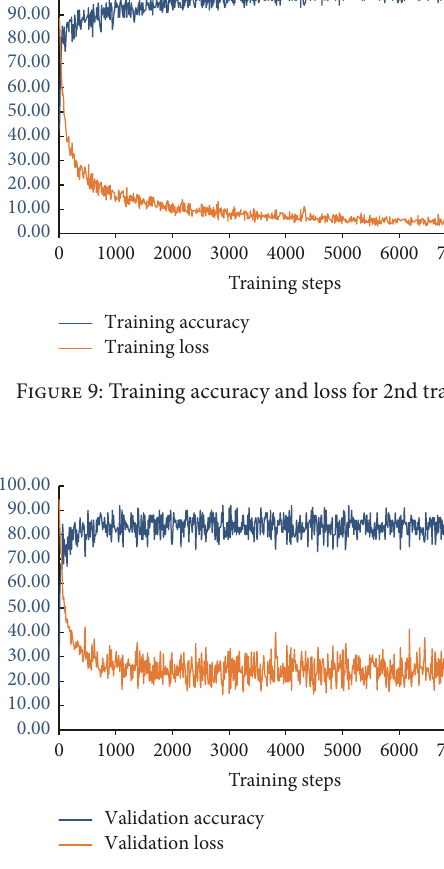
Figure 10: Validation accuracy and loss for 2nd